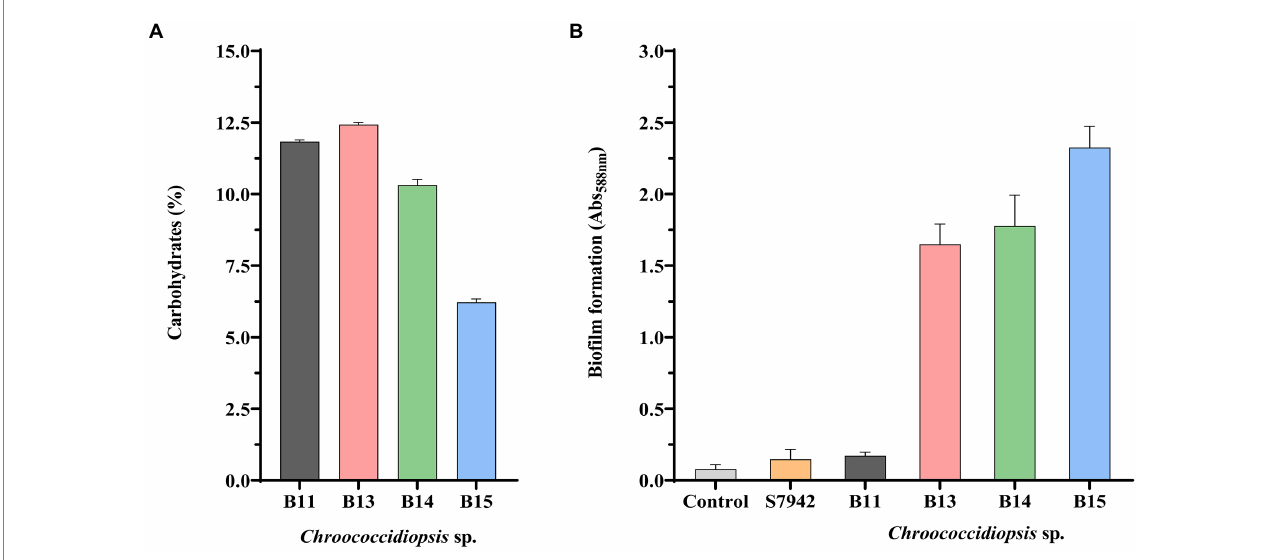
FIGURE 5 Carbohydrate content (A) and biofilm formation (B) in Chroococcidiopsis isolates. The bar charts show: (A) total carbohydrates content per cell (dried weight) (%), and (B) crystal violet staining quantification by measuring absorbance (Abs 588 nm ). S7942 is Synechococcus elongatus PCC 7942. Wells without cells were used as a control. The graphs show the average of three biological replicates together with the standard